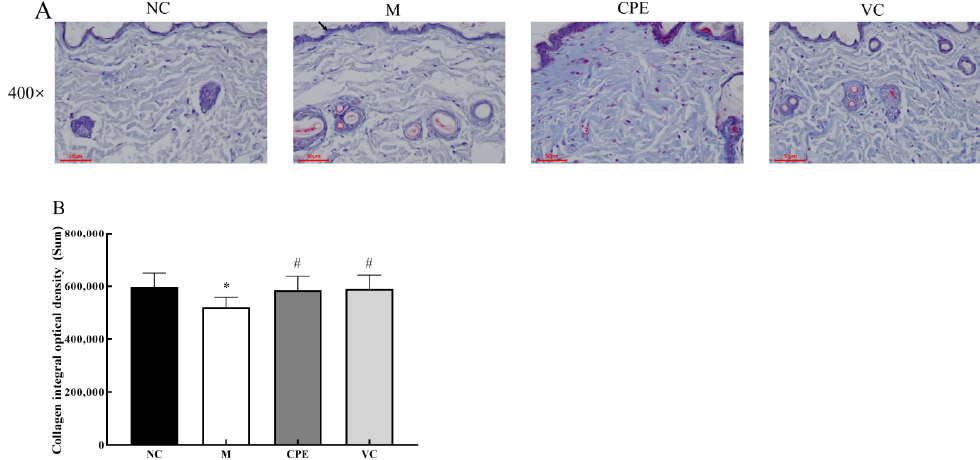
Figure 5. Results of collagen in mice skin with Masson staining. Note: ( A ): Masson -stained sections of skin tissue in each group; ( B ): Collagen IOD of skin tissue in each group. “*” indicated that the date had statistically significant differences ( p < 0.05) compared with group NC. “#” indicated that the date had statistically significant differences ( p < 0.05) compared with group M. IOD, integral optical density.